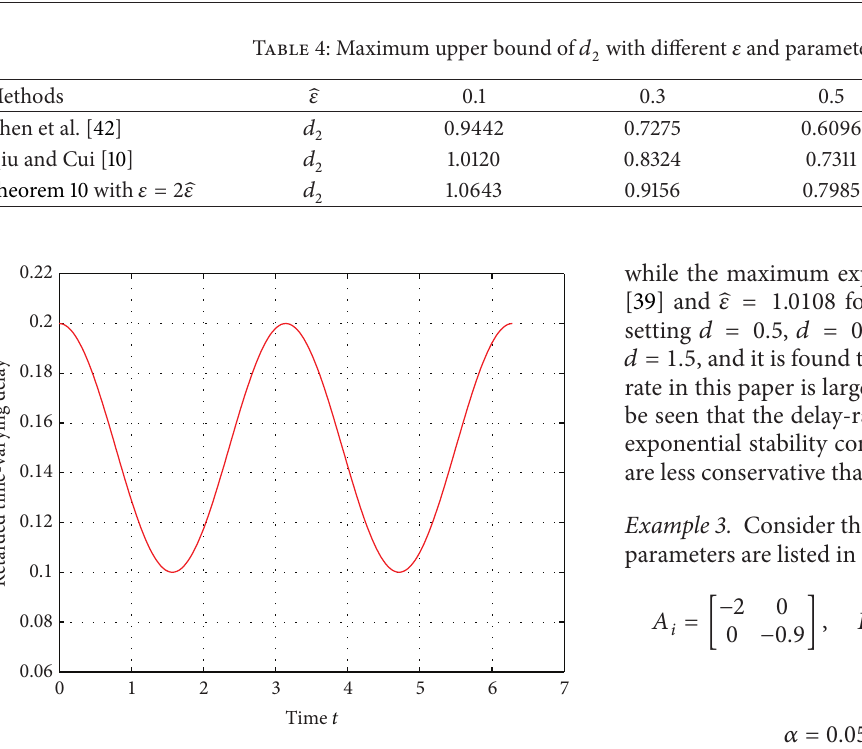
Figure 3: Interval time-varying retarded delay 𝑑(𝑡) of Example